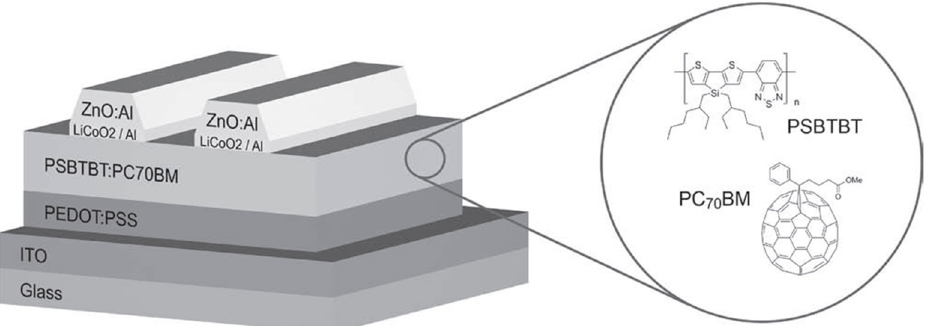
Figure 6. Left: Semitransparent photovoltaic device architecture consists of a LiCoO 2 /Al interfacial layer, a transparent cathode made of sputtered ZnO:Al, and an active layer made of PSBTBT:PC70BM. Right: Co-polymer PSBTBT and acceptor fullerene PC70BM’s molecular structure [96].